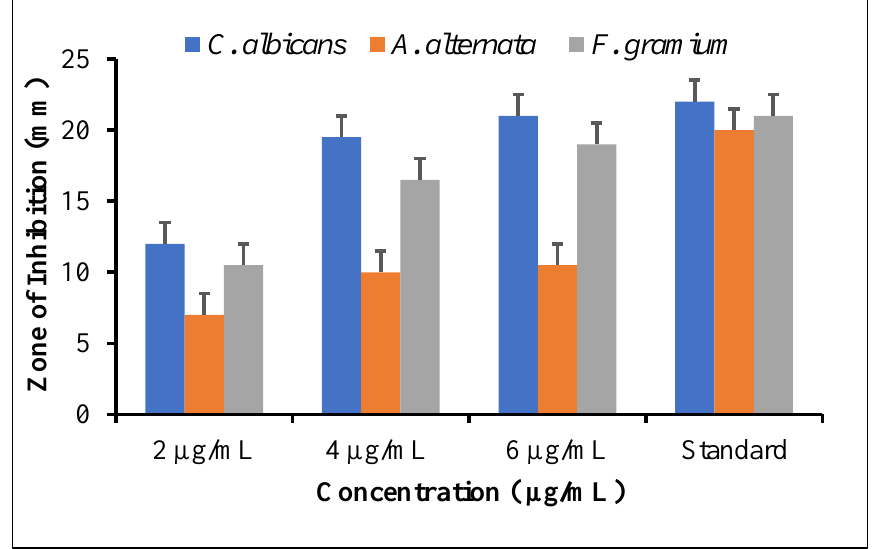
Figure 6. Antifungal activity of synthesized Ag NPs.